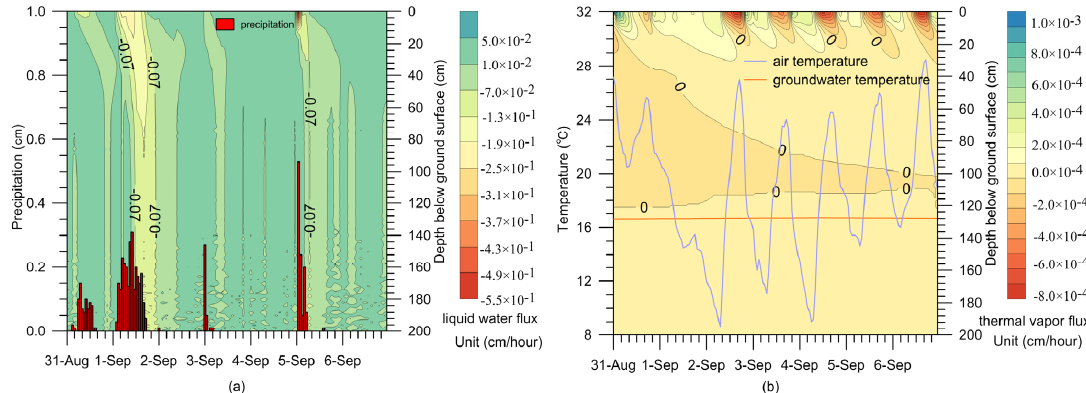
Figure 11. The movement of ( a ) liquid water; and ( b ) water vapor in autumn.